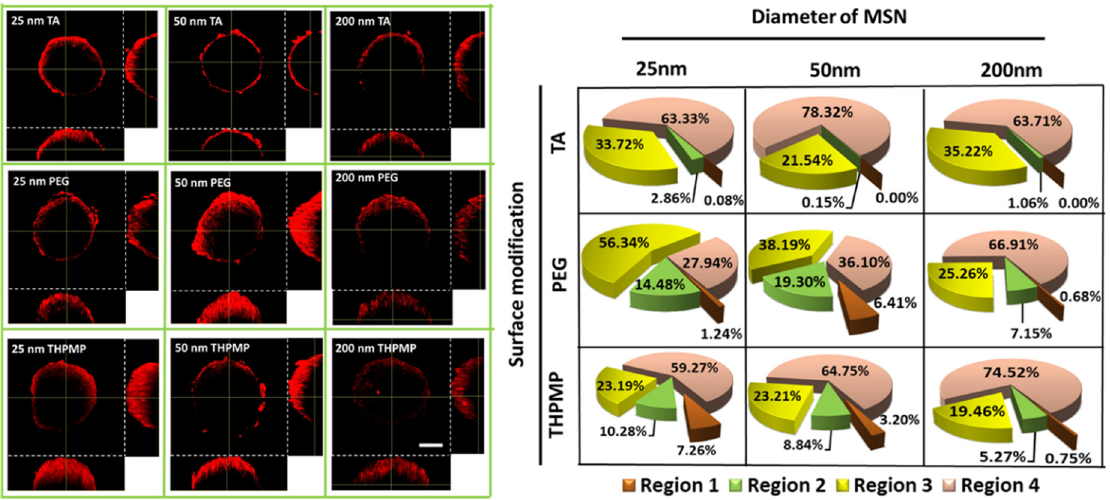
Figure 2. Two-photon images and distribution of MSNs in the middle section of fixed spheroids. Scale bar = 100 µm. N = 4.